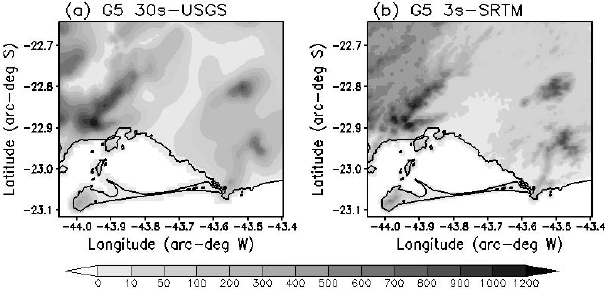
Figure 3. Shaded topographic-elevation maps for G5, processed with (a) 30arc-sec USGS and (b) 3s-STRM databases.